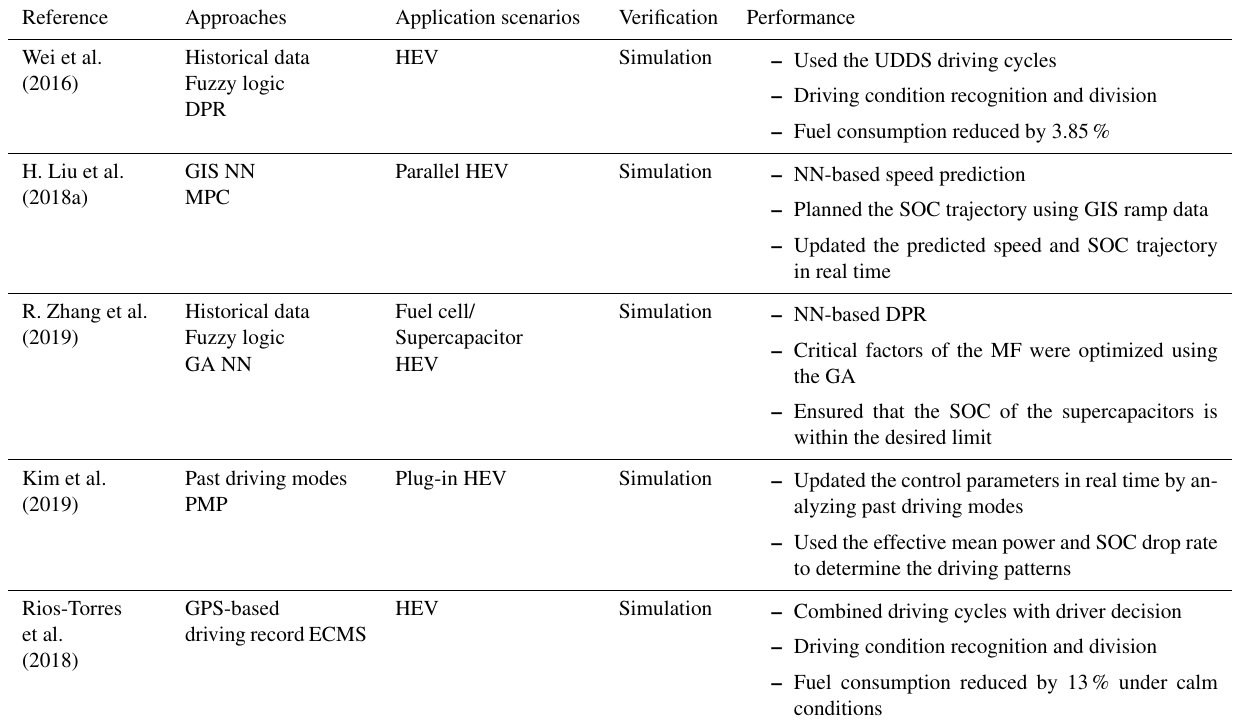
Table 15. Summary of exemplary works on ITS-based EMSs established using static